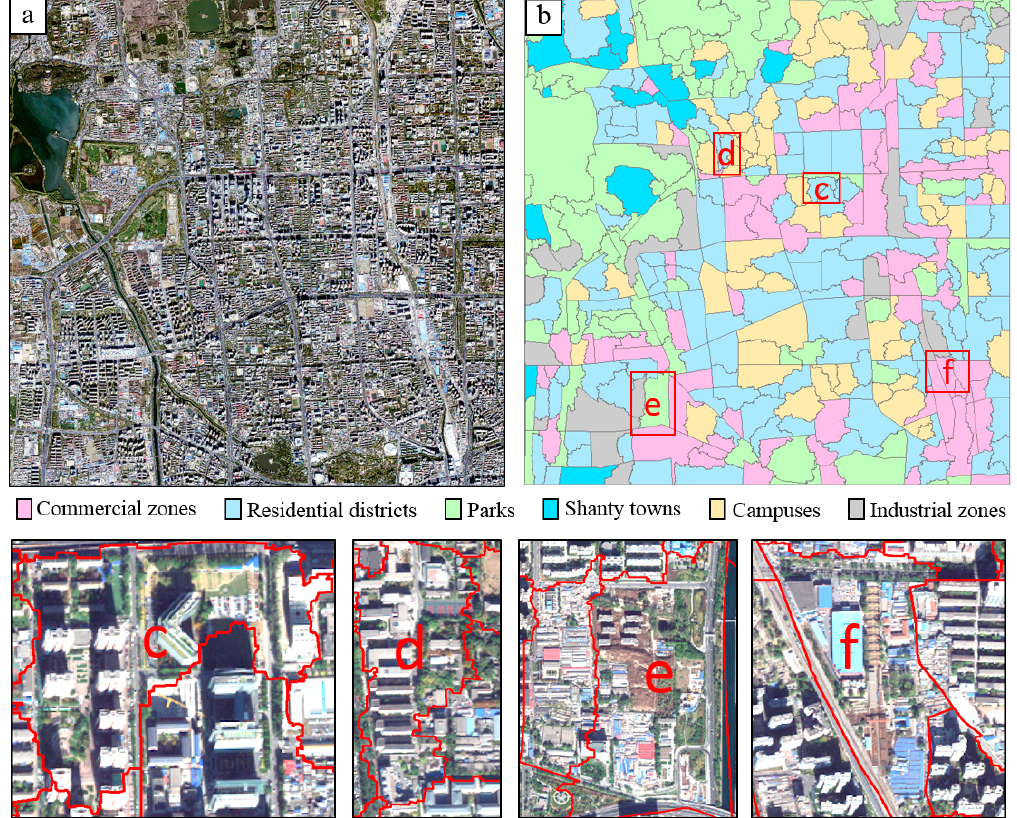
Figure 17. A comparison of: ( a ) original VHR image; and ( b ) functional-zone map. Four misclassified functional zones ( c – f ) are selected for visual interpretation.